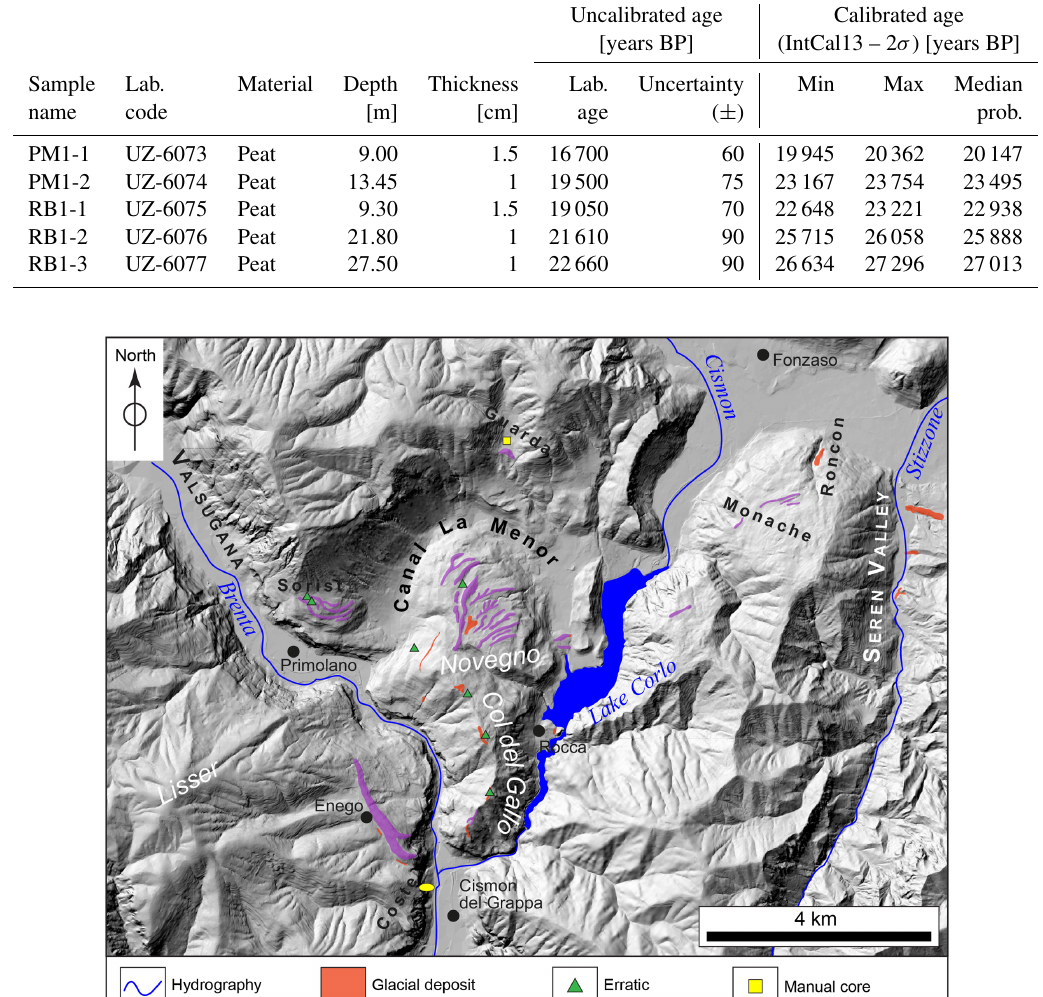
Table 1. Conventional, calibrated and median probability 14 C ages obtained from samples collected from RB1 and PM1 cores. The calibra- tion was carried out with OxCal (version 4.2, Ramsey, 2009), based on the IntCal13 calibration curve (Reimer et al., 2013).